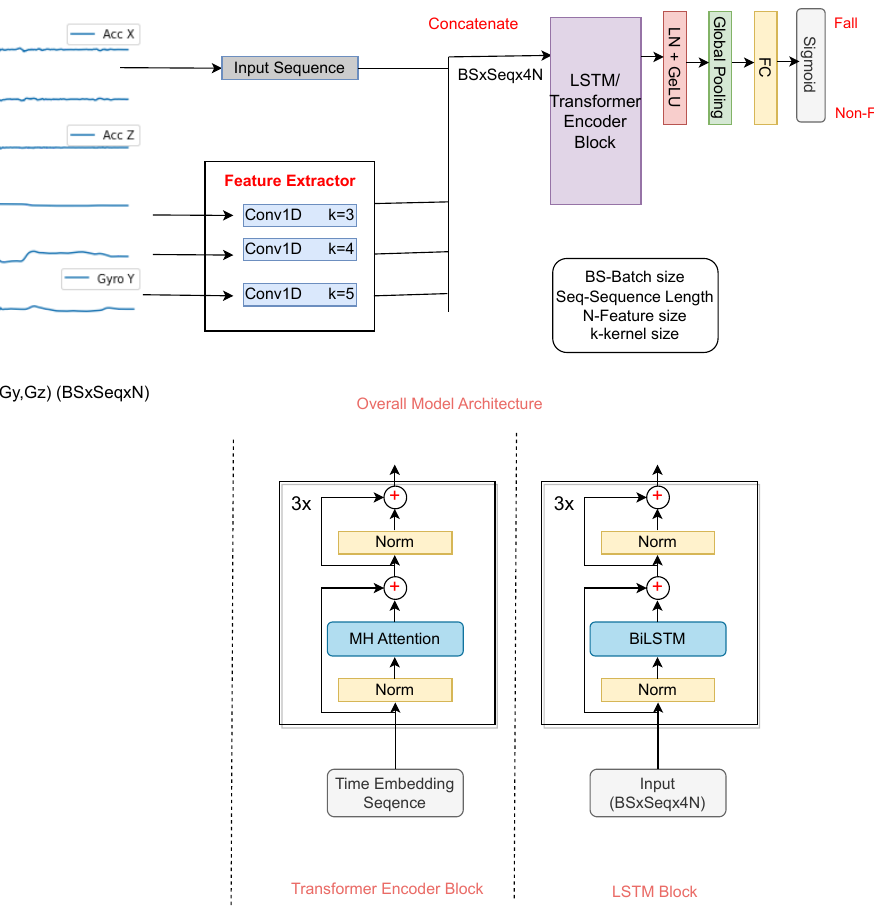
Figure 3. Overall model architecture, transformer encoder block, and LSTM encoder